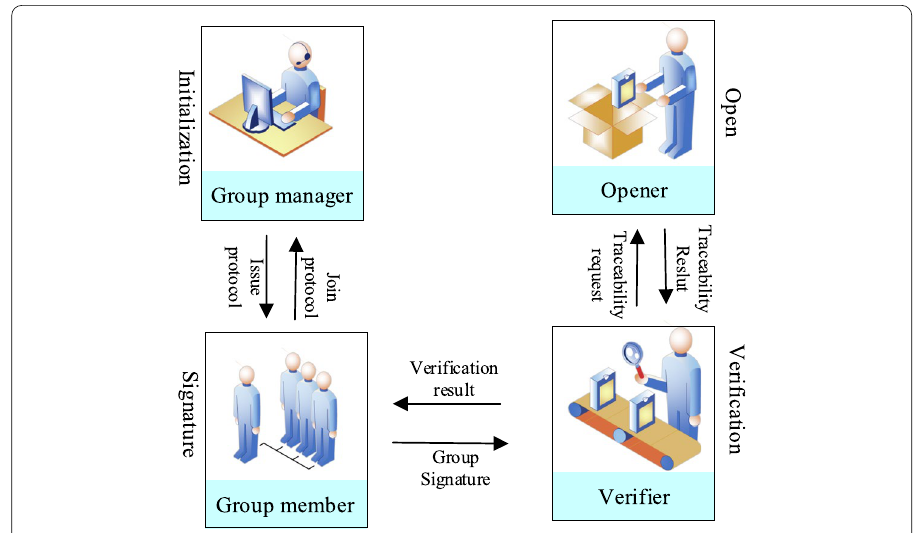
Fig. 1 The scheme of group signature. Describes the process of group signature. The scheme of GS